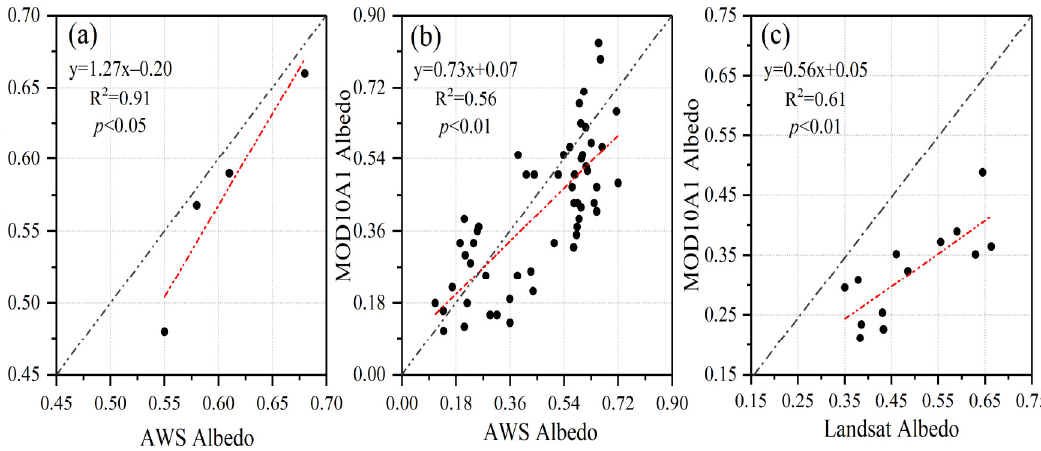
Figure 7. The scatter plots of the albedo values measured by the AWS against the values retrieved from Landsat images ( a ) and MOD10A1 ( b ). The relationship between the albedo derived from Landsat image and MOD10A1 albedo ( c ).